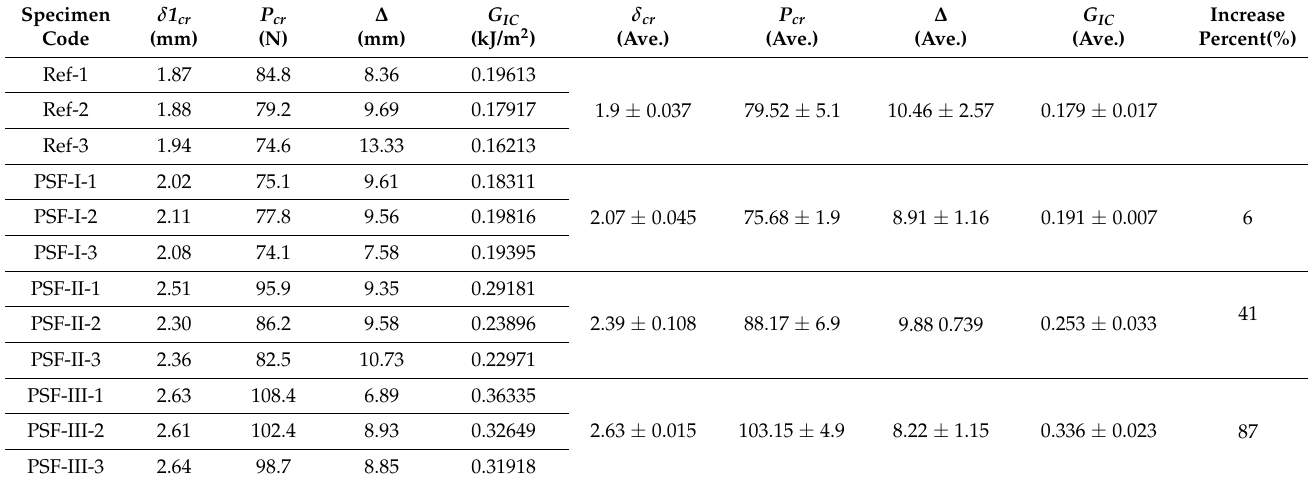
Table 2. Test parameters and fracture toughness values for the reference and PSF-modified samples. Specimen